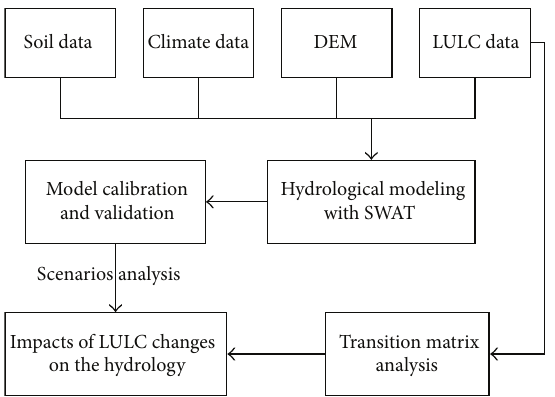
Figure 2: The conceptual framework for analyzing the impacts of LULC changes on the